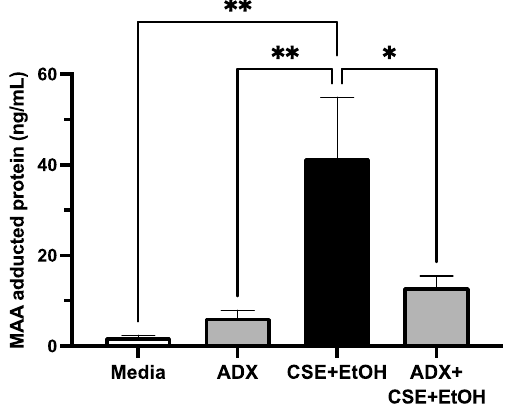
Figure 6. ADX-102 and bronchial epithelial cell permeability. 16HBE cells were grown to confluence until maximal barrier function (Resistance) achieved. Cells were treated with either DMEM and 10% serum (Media), 5% cigarette smoke extract (CSE), 50 mM alcohol (EtOH), or the combination of smoke and alcohol for up to 72 h in the absence ( A ) or presence ( B ) of 10 µM ADX-102. * p < 0.02 vs. media at 72 h. Bars represent SEM of n = 5, each with three replicates.